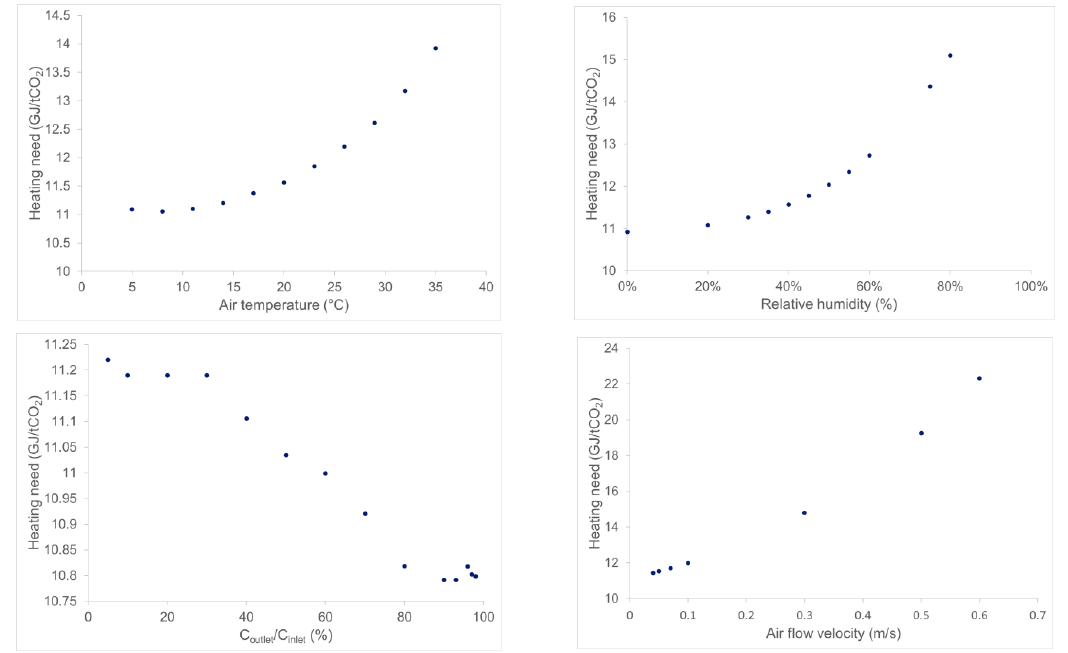
Figure 6. Results of the parametric studies on the specific heating need of the process at the lab scale. When increasing the breakthrough level (Figure 6, bottom-left), the cyclic capacity